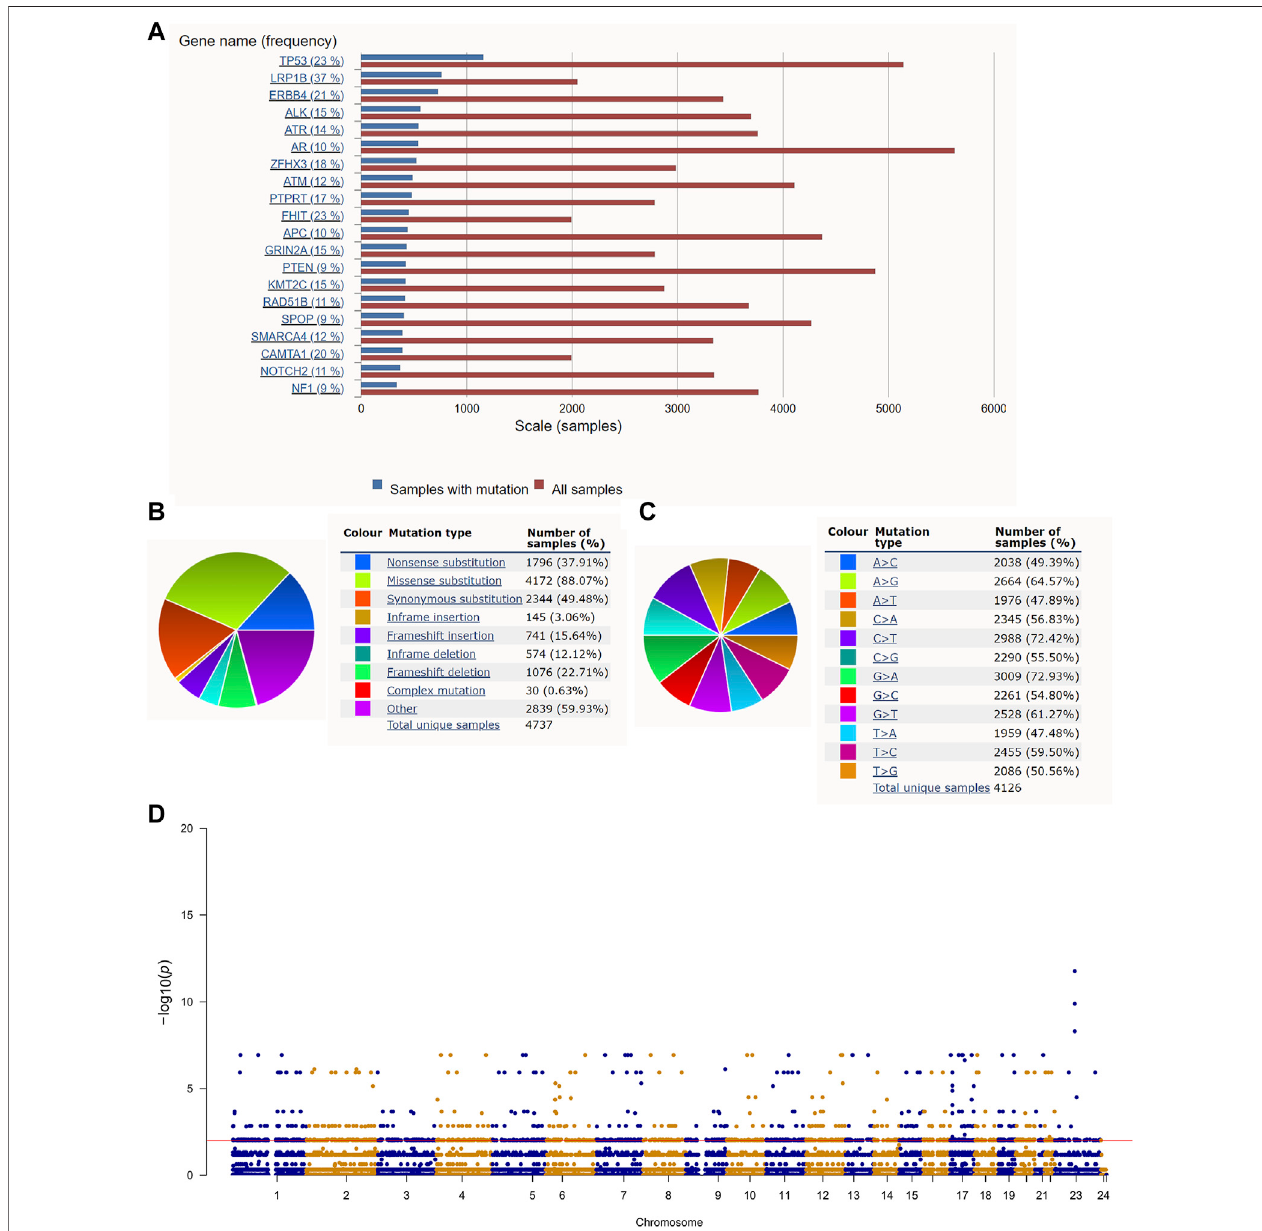
FIGURE 2 | Gene mutation in prostate cancer: (A) The top 20 mutated genes in prostate cancer. (B,C) The distribution of different types of mutations in prostate cancer. (D) The Manhattan plot of mutation sites that have signi fi cantly different mutation frequencies between primary and metastatic prostate cancer.